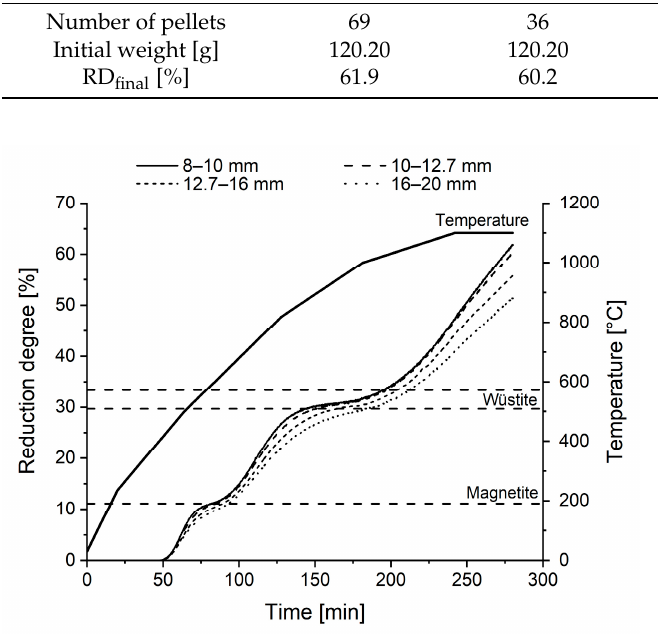
Figure 5. Reduction degree as a function of experimental time for different-sized pellets.